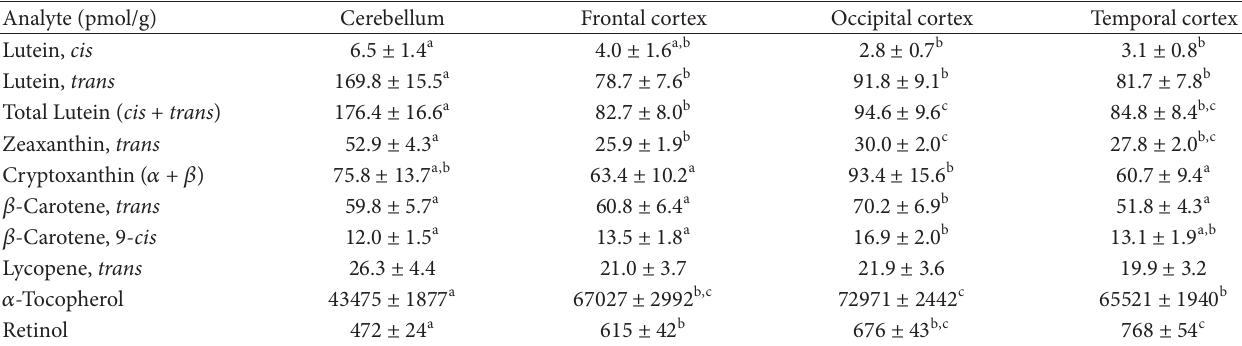
Table 4: Mean ( ± SEM) concentrations of carotenoids, 𝛼 -tocopherol, and retinol in the cerebellum, frontal, occipital, and temporal cortices ( 𝑛 = 47 ).